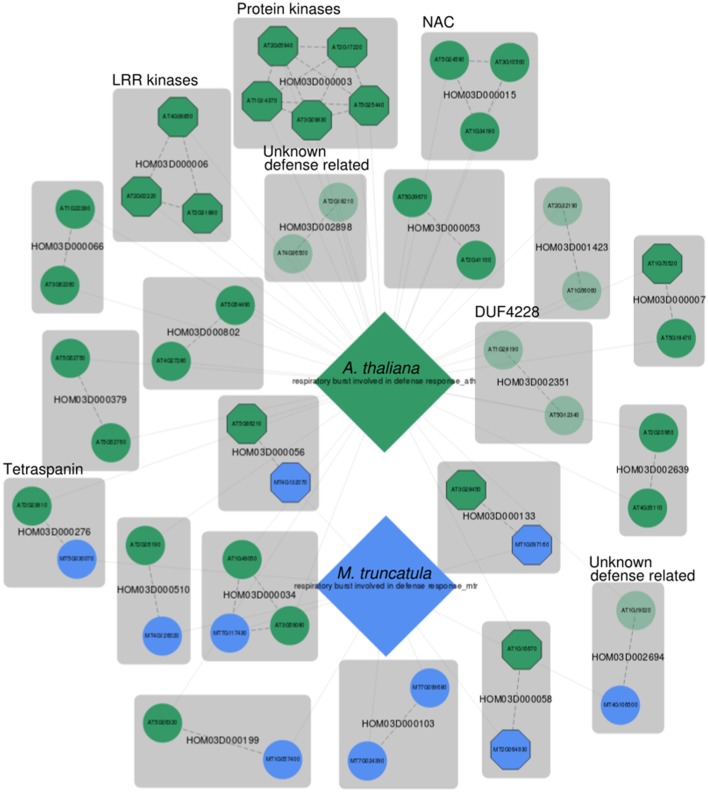
MorphDB network for GO:0002679 (respiratory burst involved in defense response) for A. thaliana (green) and M. truncatula (blue). For more details, see Figure 2.